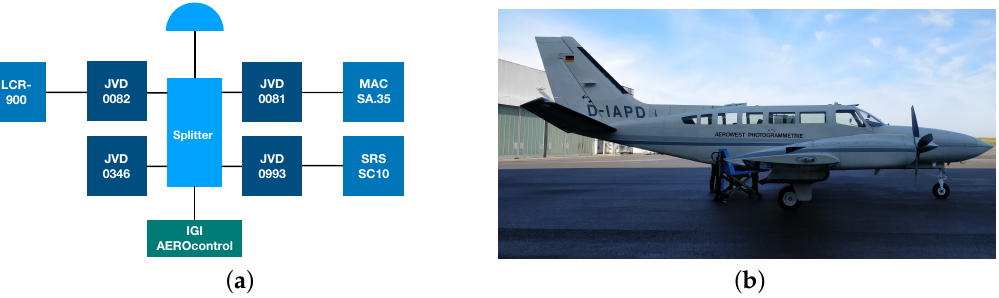
Figure 2. Flight experiment. ( a ) Measurement configuration, ( b ) aircraft used during the